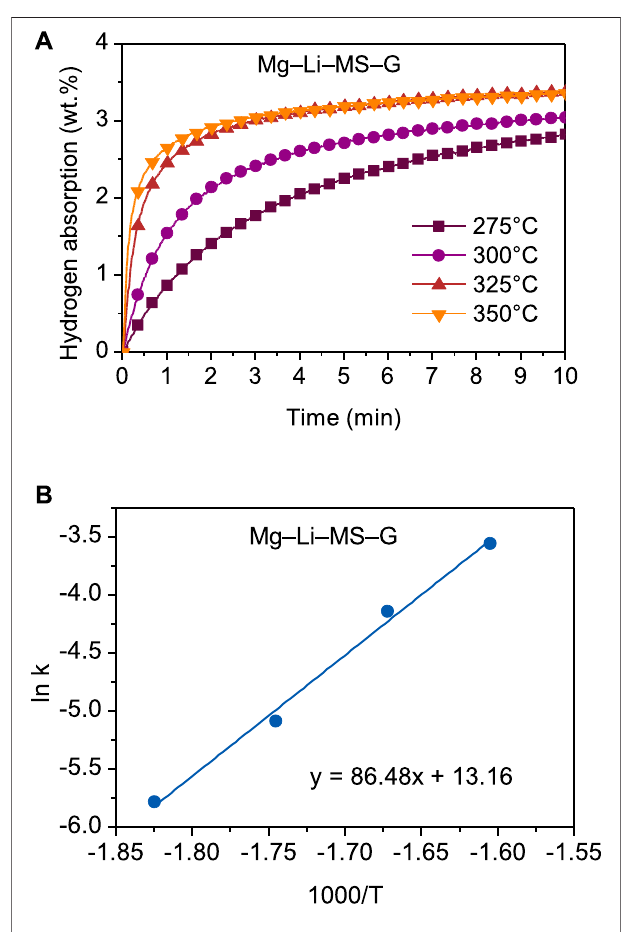
FIGURE 6 | Hydrogenation curves under different temperatures (A) and Arrhenius ’ s plot (B) of the Mg − Li − MS − G composite.